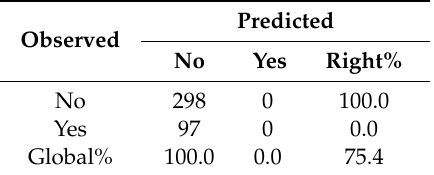
Table 8. Classification success for using